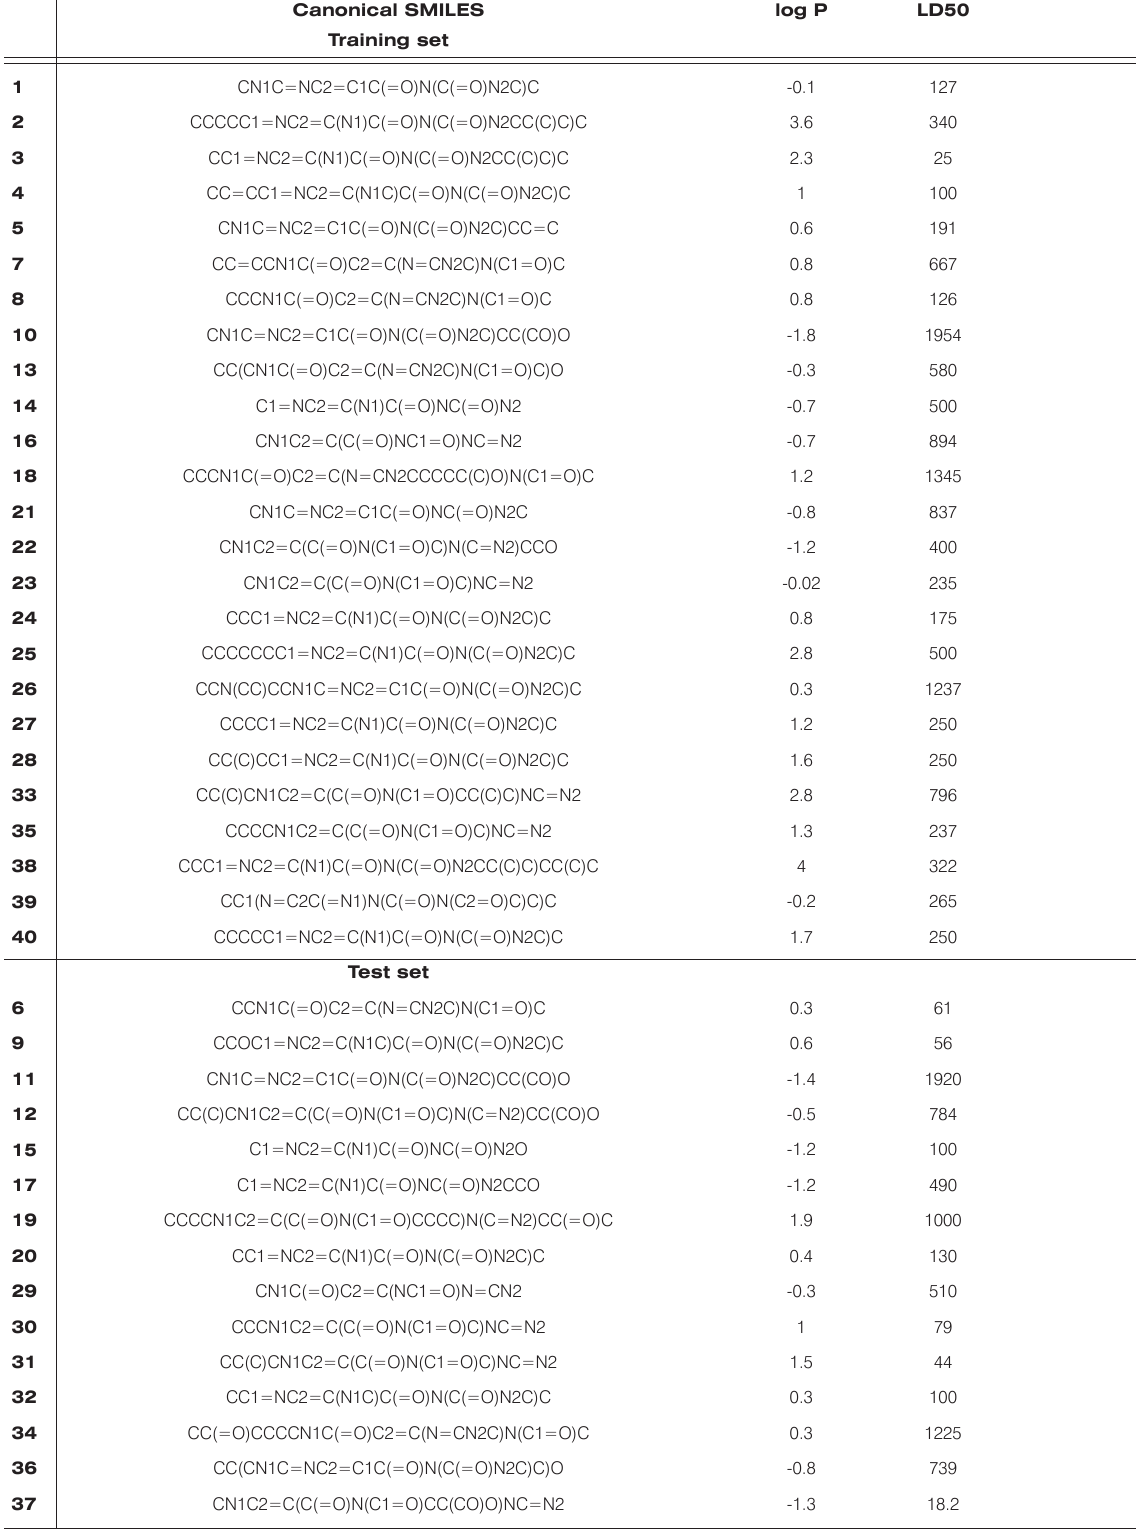
Table 1. Caffeine molecular structures (in SMILES code) and their log P (taken from PubChem). Canonical